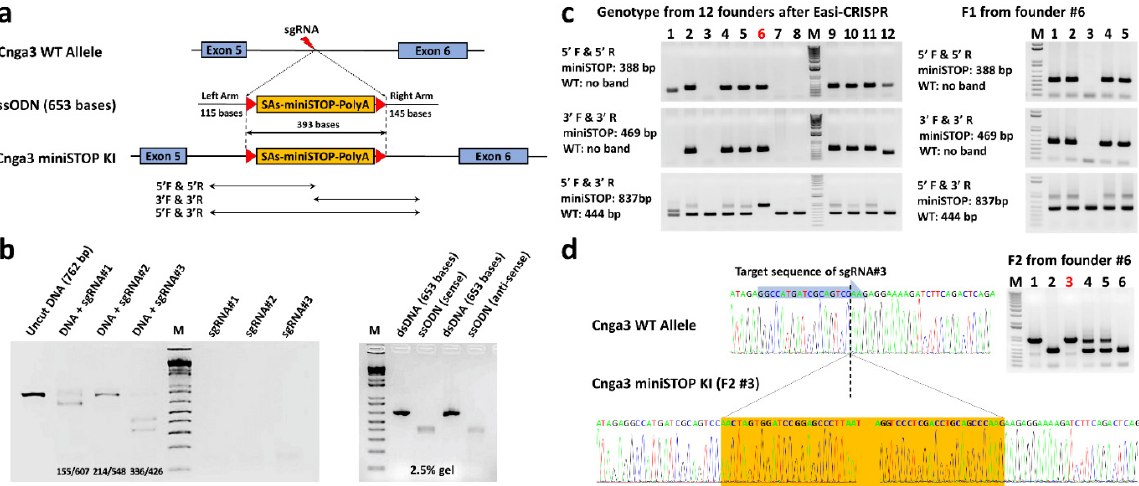
Table 1. Sequence of sgRNAs.